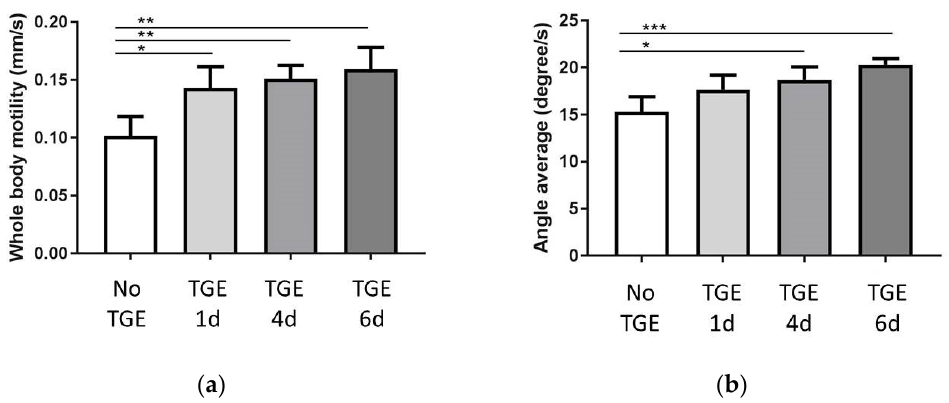
Figure 3. Whole body motility ( a ) and bending angle average ( b ) at the end of the experiment (12 days) after TGE over one, four, and six days. In each experimental group the mean and standard deviation of four individual experiments is displayed with * p < 0.05, ** p < 0.01, *** p < 0.001.